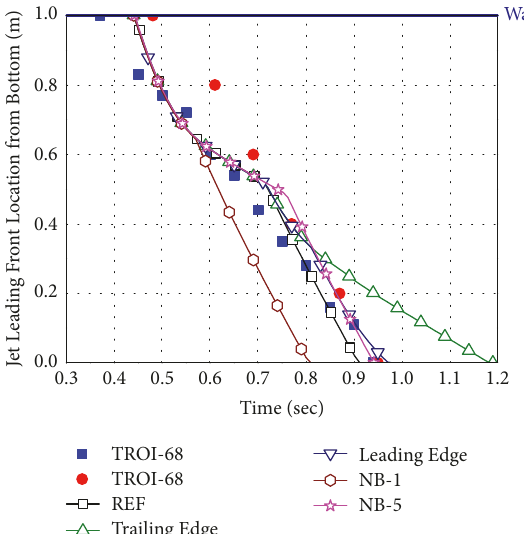
Figure 5: Results of sensitivity analysis for melt particle locations in partially flooded cavity condition.